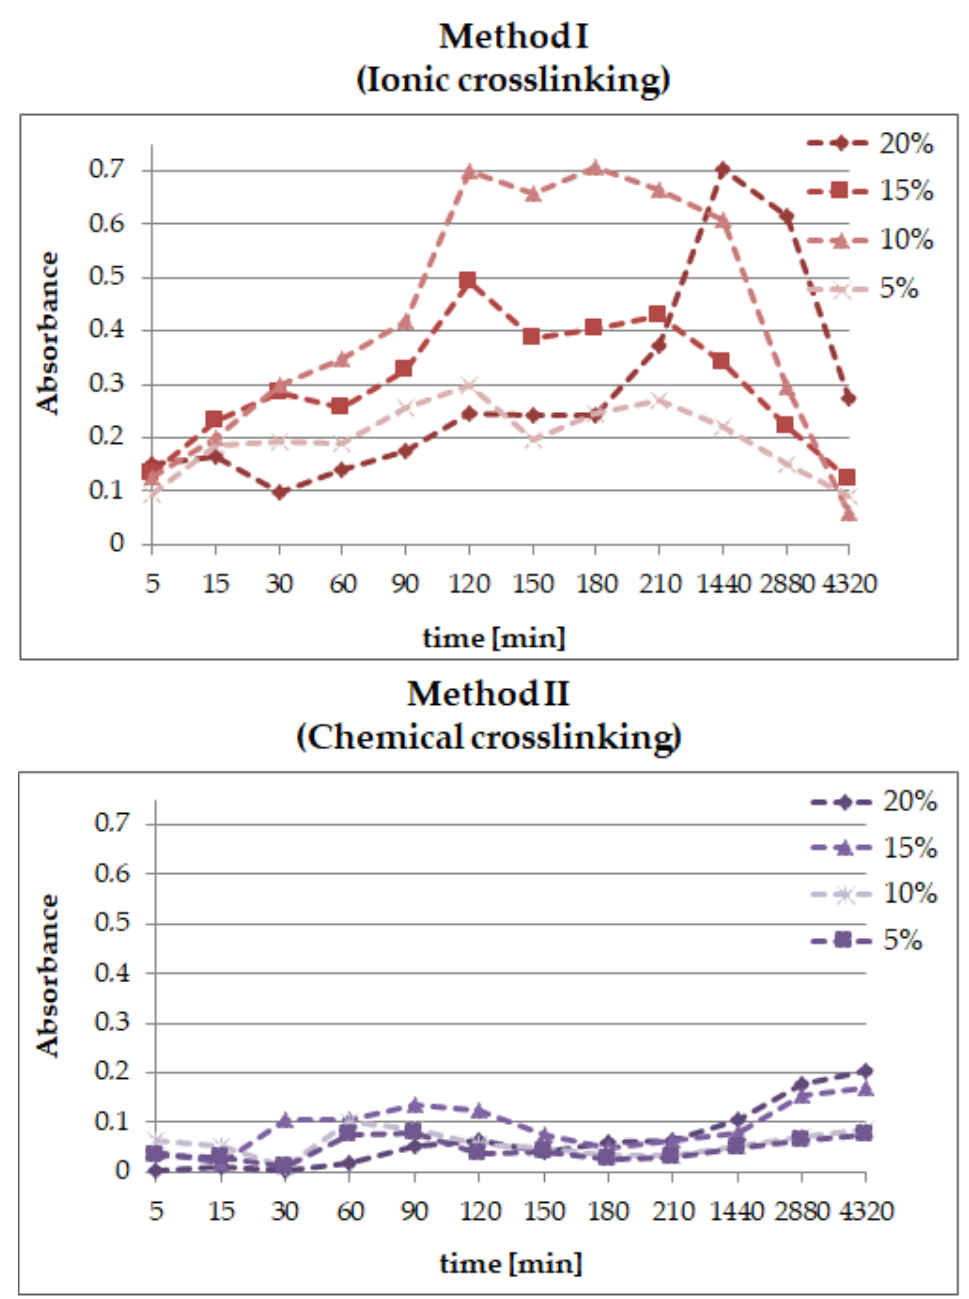
Figure 8. Release profiles of echinacoside from hydrogels prepared using method I (ionic crosslinking) or method II (chemical crosslinking).